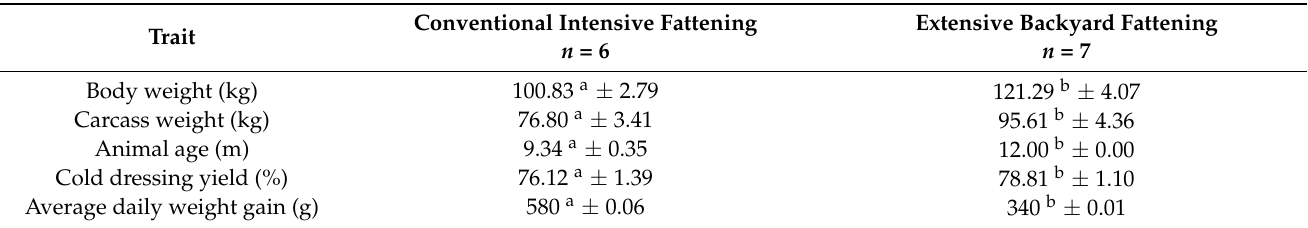
Table 3. Growing performance and carcass yield of pigs fed according to intensive conventional or extensive traditional systems (means ± SD).